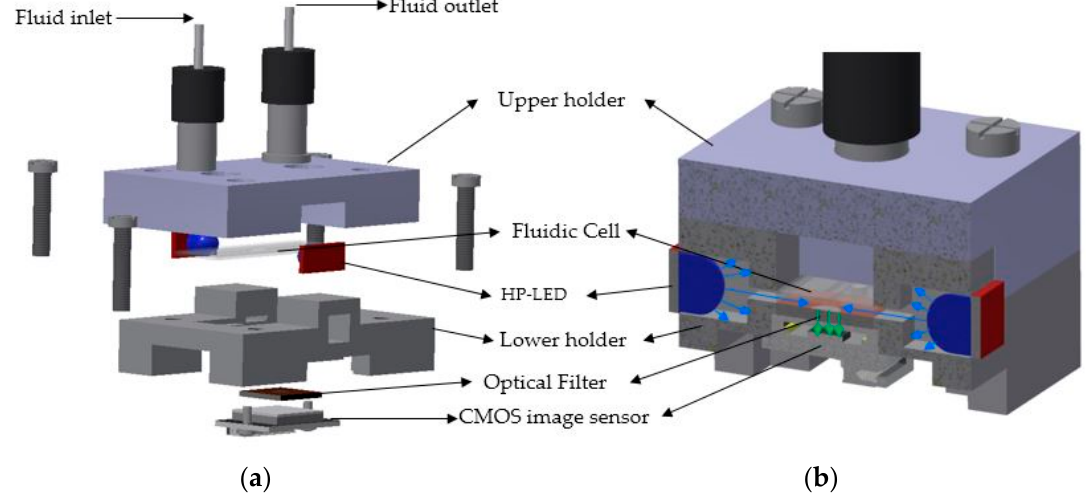
Figure 2. The concept of the complementary metal-oxide-semiconductor (CMOS)-based fluorescence detector (46 mm × 30 mm × 10 mm). ( a ) Exploded view of the detector. ( b ) Transversal cross-section of the assembled sensing device.